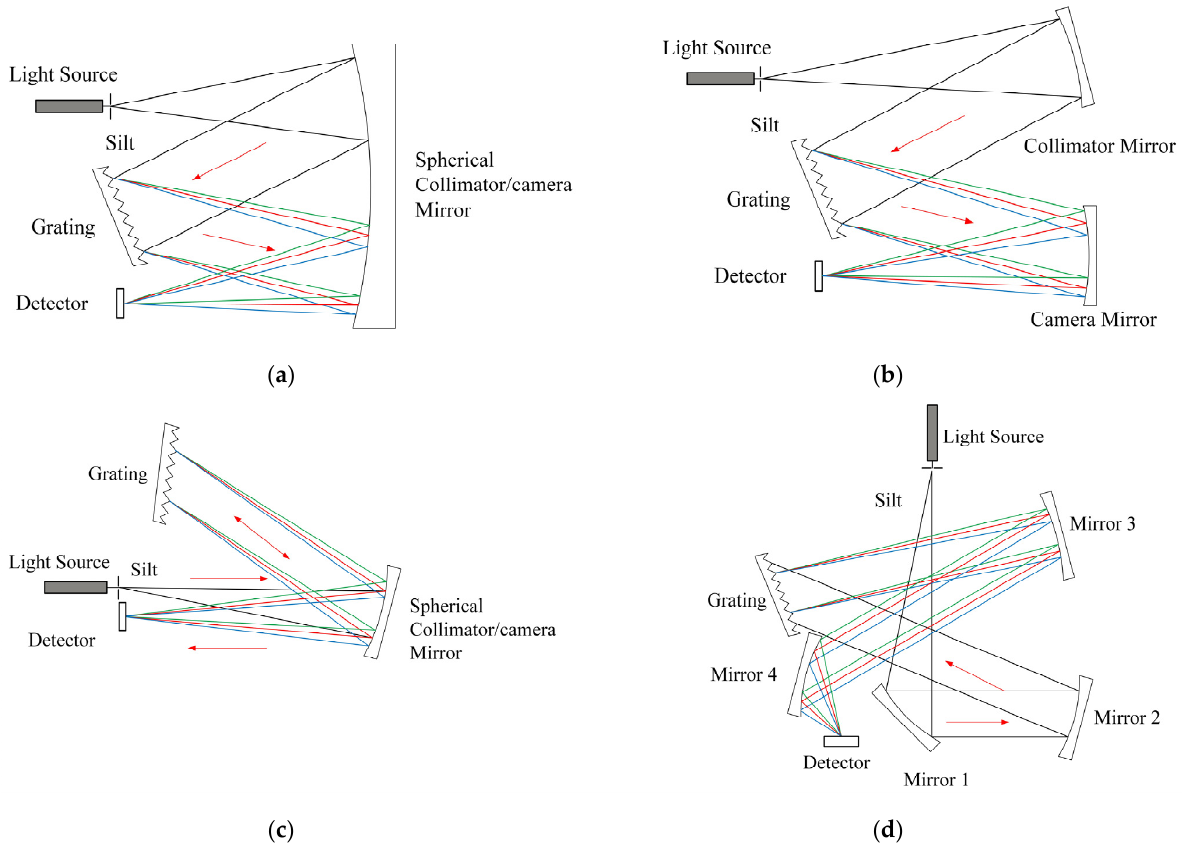
Figure 7. Optical structures of typical plane grating spectrographs:( a ) Ebert-Fastie; ( b ) Czerny-Turner;